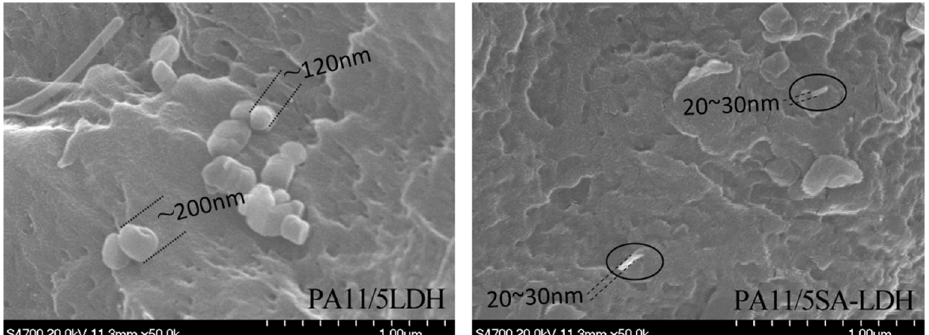
Figure 4. SEM images of PA11/LDH and PA11/SA-LDH composites.